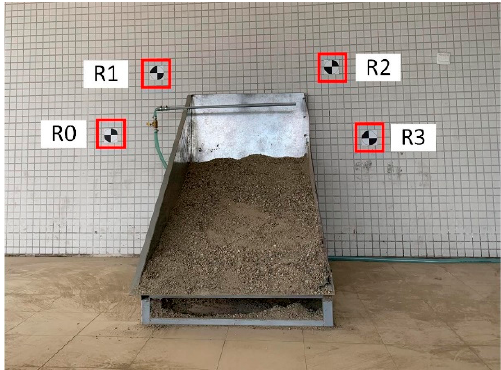
Figure 7. Layout of geodetic control points.